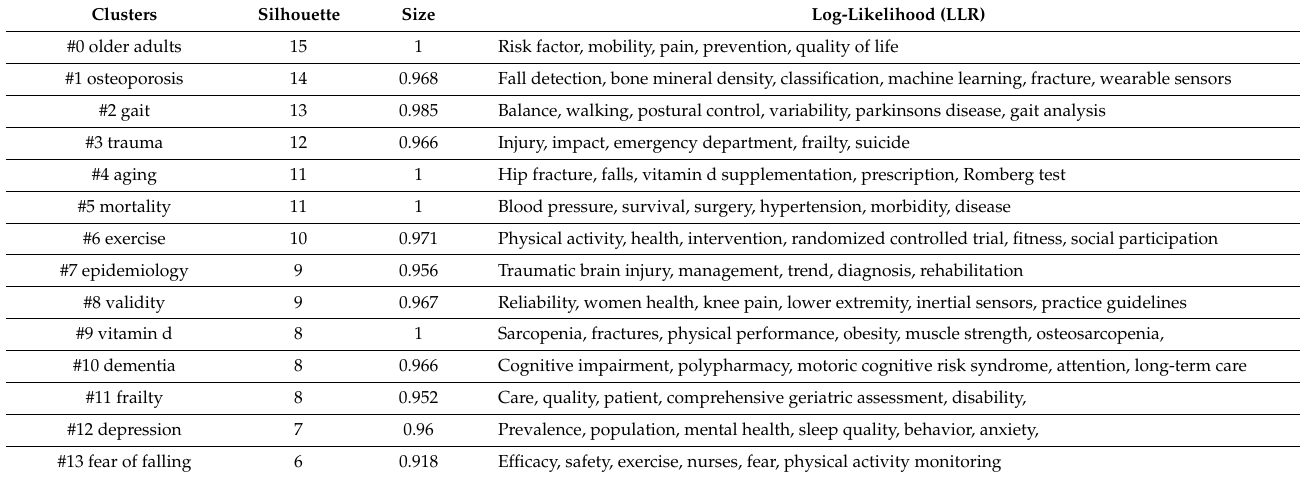
Table 4. Subjects of cluster analysis (2010–2020).